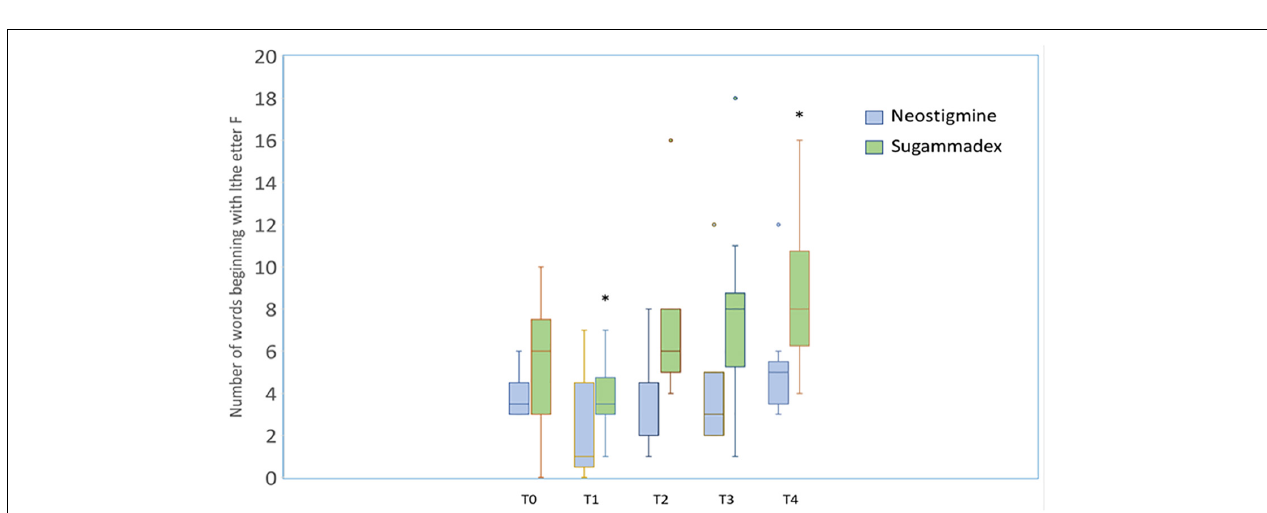
FIGURE 4 | Boxplot diagram showing the effects of neostigmine (blue) and sugammadex (green) on cognitive level by asking a patient to name as many words as he/she could beginning with the letter “F” at different times before surgery ( t = 0, T0) and 30 min (T1), 24 h (T2), 72 h (T3), and 30 days after surgery (T4). No differences were found among different times in patients receiving neostigmine, whereas statistically significant differences (* p < 0.05) were detected 30 min (T1) ( p = 0.007) and 30 days (T4) ( p = 0.005) after surgery when compared to data obtained prior to surgery